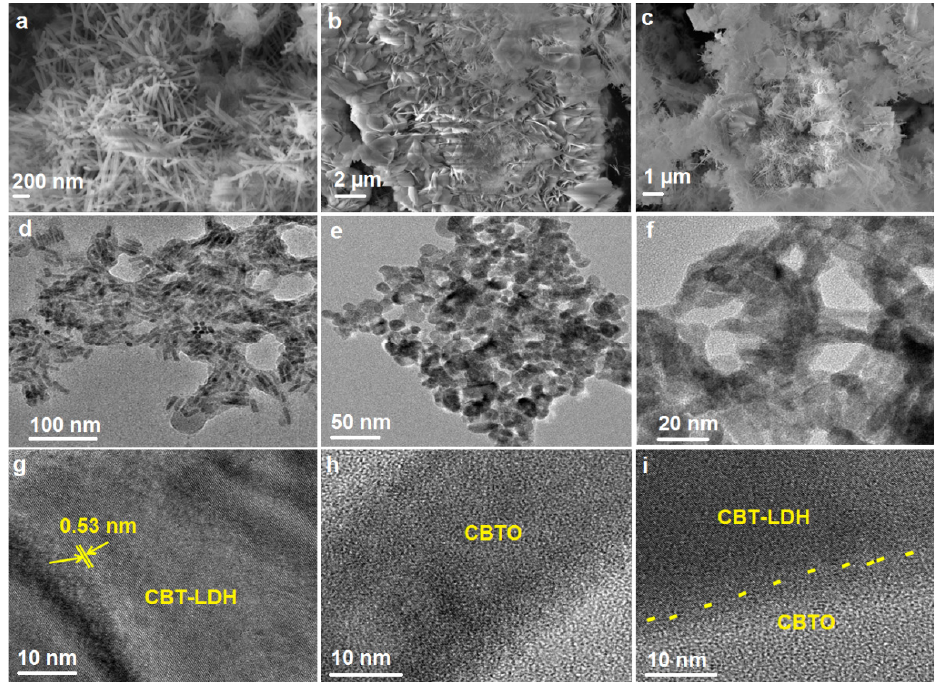
Figure 10. The surface structure/heterojunction of the prepared CBT/CBTO semiconductors [108]. The images express ( a – c ) SEM, and ( d – f ) HRTEM captures of CBT-LDH, CBTO, and the CBT- LDH/CBTO photocatalysts. The images ( g –i) the crystal lattice fringes of the synthesized photocatalysts. Copyright 2022, reproduced with permission from Elsevier.